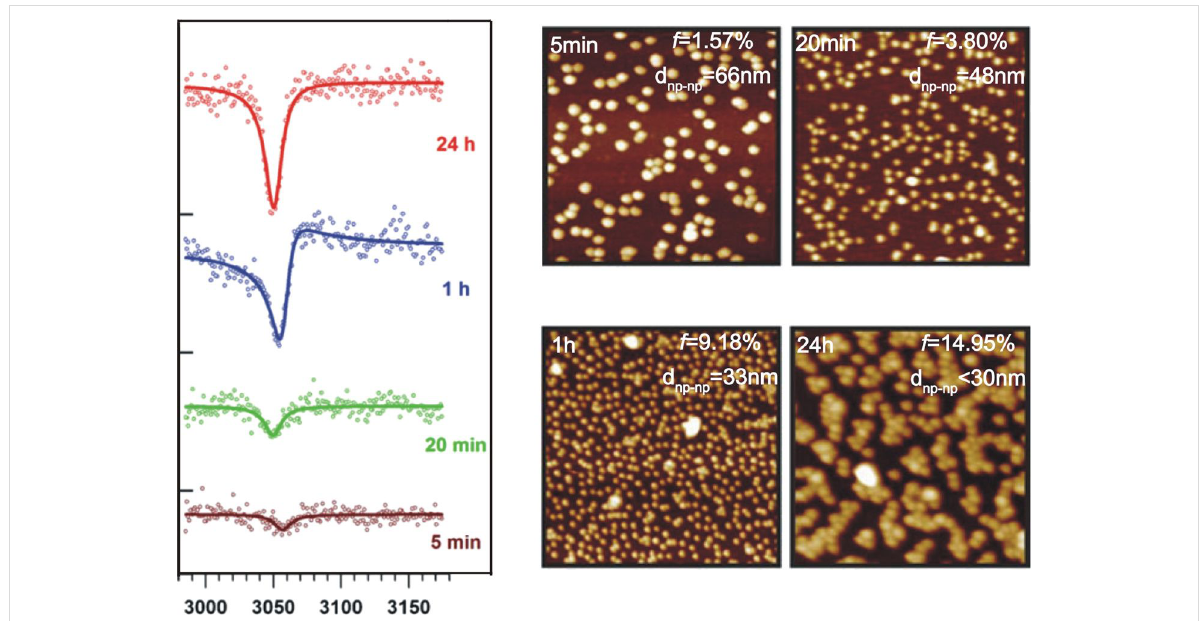
Figure 6: ( Left) SFG spectra of silicon substrate immersed in a colloidal solution of gold NPs (17 nm diameters) for increasing times and subse- quently functionalized with thiophenol. Depending on the immersion time, the NPs surface coverage ranged from 1.5 to 15%. (Right) Corresponding SEM images showing the progressive surface coverage with immersion time. Figure adapted with permission from [71], Copyright 2013 Springer, and from [72], Copyright 2012 Royal Society of